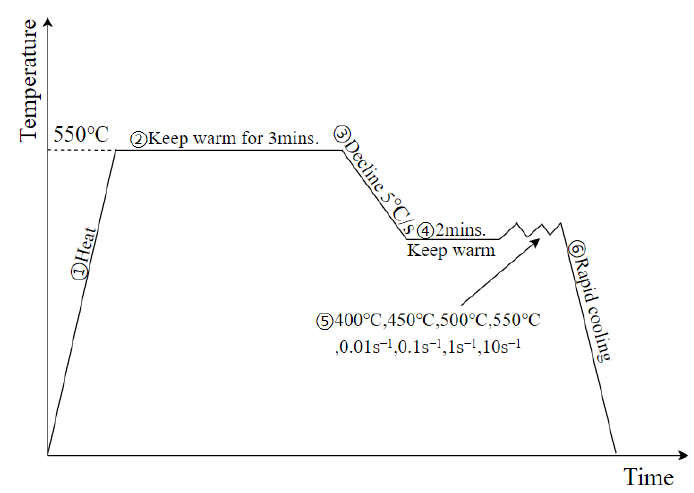
Figure 2. Temperature and deformation processes of the specimen.